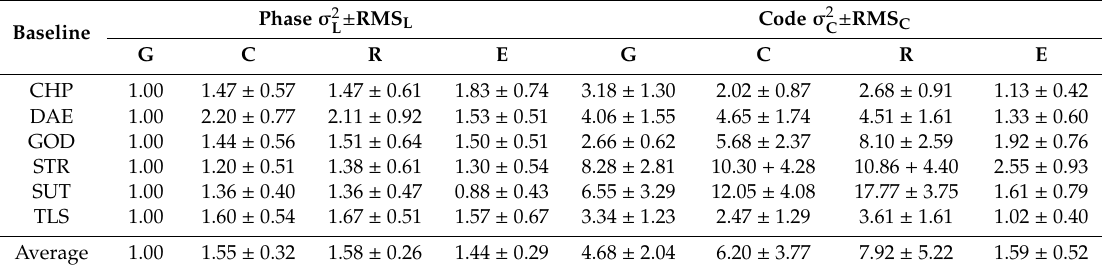
Table 4. Average phase and code variances of unit weight calculated by HVCE Multi-GNSS strategy and their corresponding root mean square (RMS) values from DoY 171 to 200 in